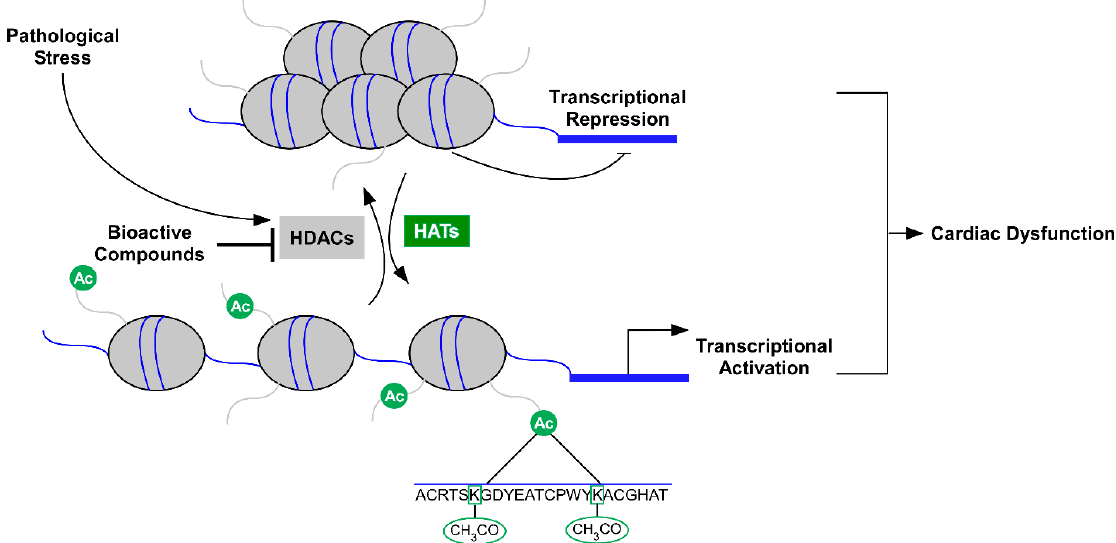
Figure 2. Model demonstrating that food bioactives (phytochemicals) inhibit histone deacetylase (HDAC) activity as a cardio-protective mechanism. HDACs catalyze the removal of acetyl groups from lysine residues on histone tails. Deacetylation of histones leads to changes in electrostatic interactions between DNA and histone proteins that lead to chromatin condensation and gene repression. Conversely, histone acetyl transferases (HATs) add acetyl marks contributing to relaxed chromatin and gene expression. Increased HDAC activity is linked to cardiac dysfunction while inhibition of HDACs is cardio-protective. Thus, food bioactive HDAC inhibitors promote heart health via epigenetic regulation of gene